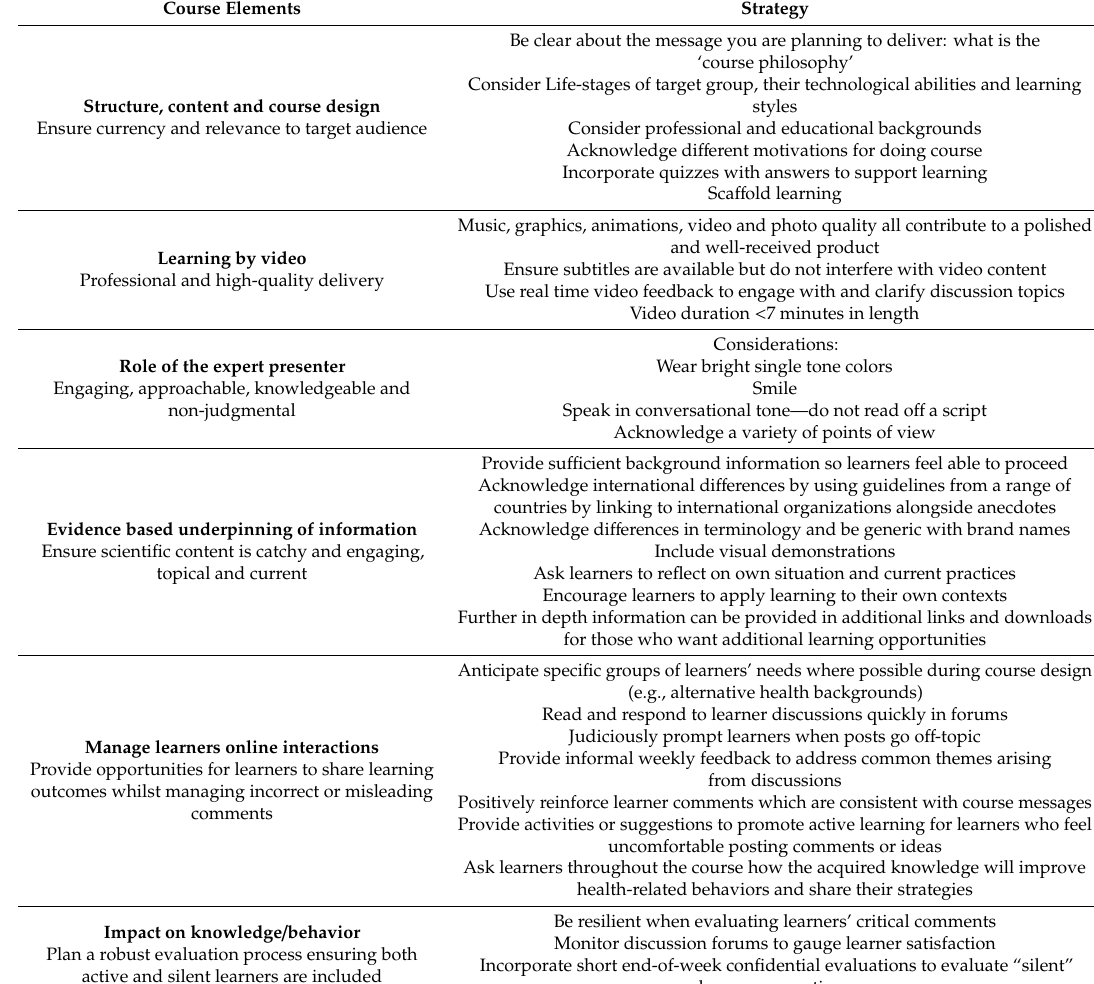
Table 1. Top tips for successful Massive Open Online Courses